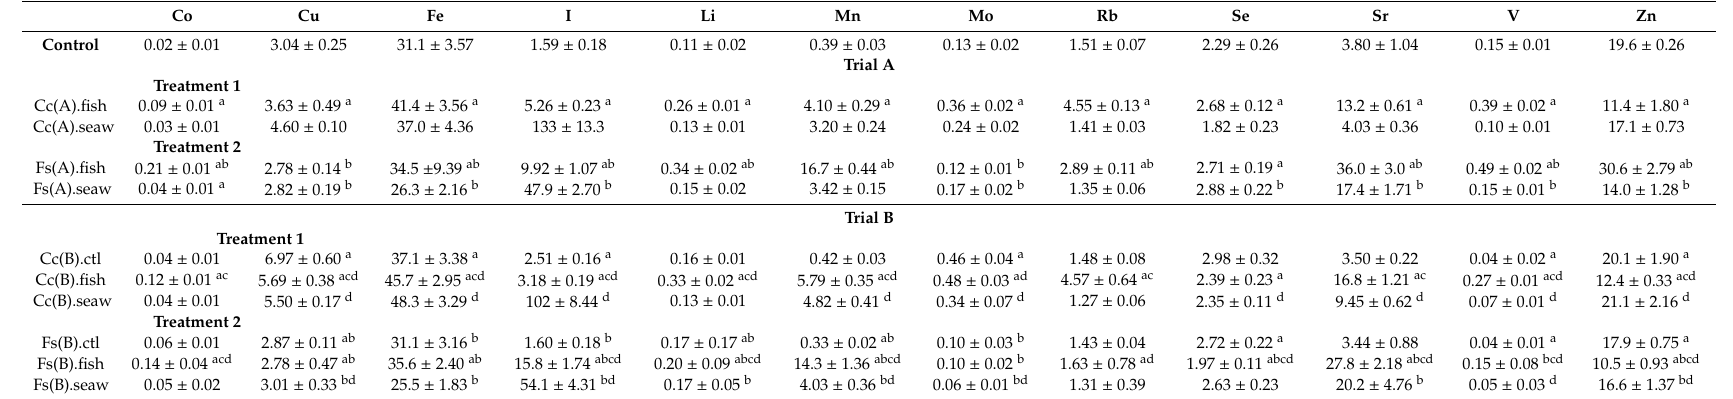
Trial A (addition of seaweeds in the canning step), Trial B (addition of seaweeds as a replacement for salt added in the brining step and subsequent addition of seaweeds in the canning step). Data represent the mean ± SD of six canned samples, analysed in duplicate. Statistical significance was determined by the Tukey’s post hoc test at: a p < 0.05 versus the Control sample; b p < 0.05 versus the respective sample (fish / seaweed) obtained in Treatment 1 (in Trial A and B); c p < 0.05 versus Cc(B).ctl or Fs(B).ctl obtained in Treatment 1 and 2 (in Trial B), and d p < 0.05 versus the respective fish sample (Cc(A).fish, Fs(A).fish) or seaweed sample (Cc(A).seaw or Fs(A).seaw) obtained in Treatment 1 and 2 (in Trial